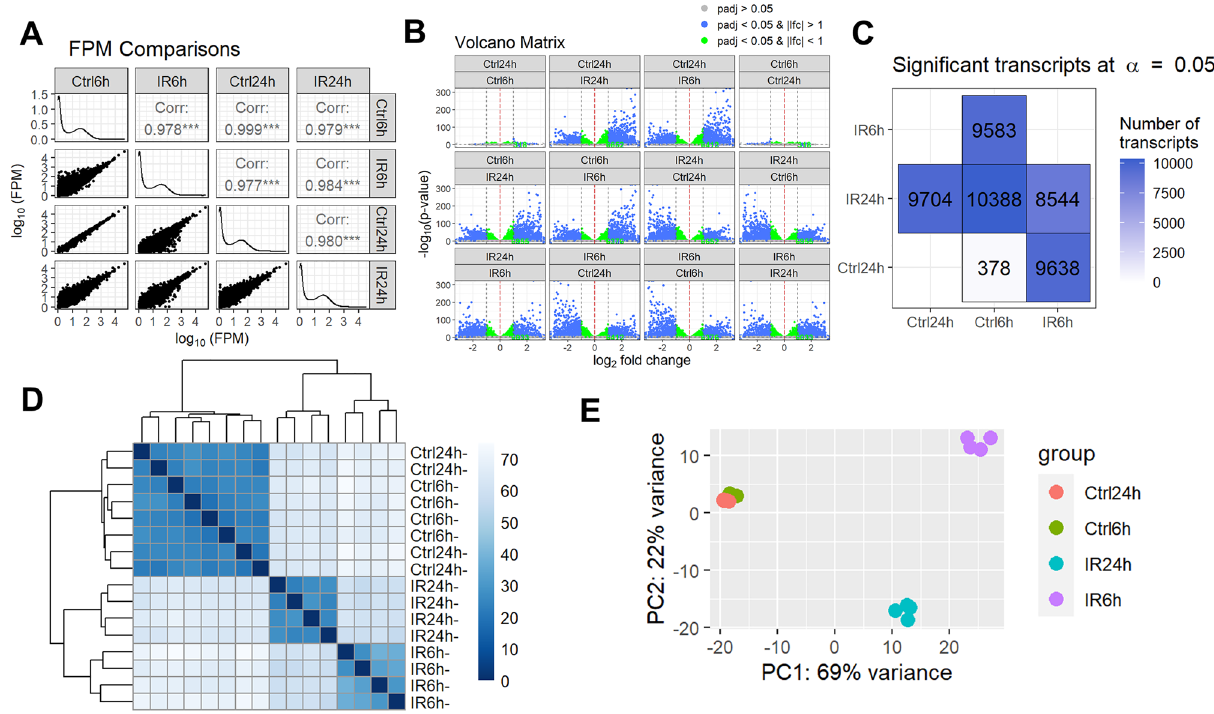
Figure 2. Ischemia leads to significant changes in gene expression in the retina 6 and 24 h after reperfusion. ( A ) A scatter plot matrix was used to visualize the correlation between gene expression in ischemic (IR) and normotensive (Ctrl) retinas 6 and 24 h after reperfusion. Correlation (Corr) values and FPM distributions (histograms) were generated. ( B ) A volcano plot matrix was used to combine all volcano plots for all comparisons. Each volcano plot shows the difference between two variables (either Ctrl6h, Ctrl24h, IR6h, or IR24h) in terms of gene expression values: − log10 of calculated p value (y-axis) is plotted against log2 fold change (x-axis). As follows from our data, the greatest difference is observed in combinations of IR6h versus Ctrl6h, IR6h versus Ctrl24h, IR24h versus Ctrl6h, IR24h versus Ctrl24h, and IR6h versus IR24h, while there is no significant difference between Ctrl6h versus Ctrl24h. ( C ) A matrix of differentially expressed genes (DEGs) at an adjusted p value (padj = 0.05) is consistent with the volcano plot matrix indicating that ischemia leads to a rapid change in gene expression 6 and 24 h after reperfusion. ( D , E ) A heatmap of the sample-to-sample distances (sample clustering, D ) and the principal component (PCA) plot of the samples ( E ) show similar dynamics in the development of IR retinal pathology as obtained